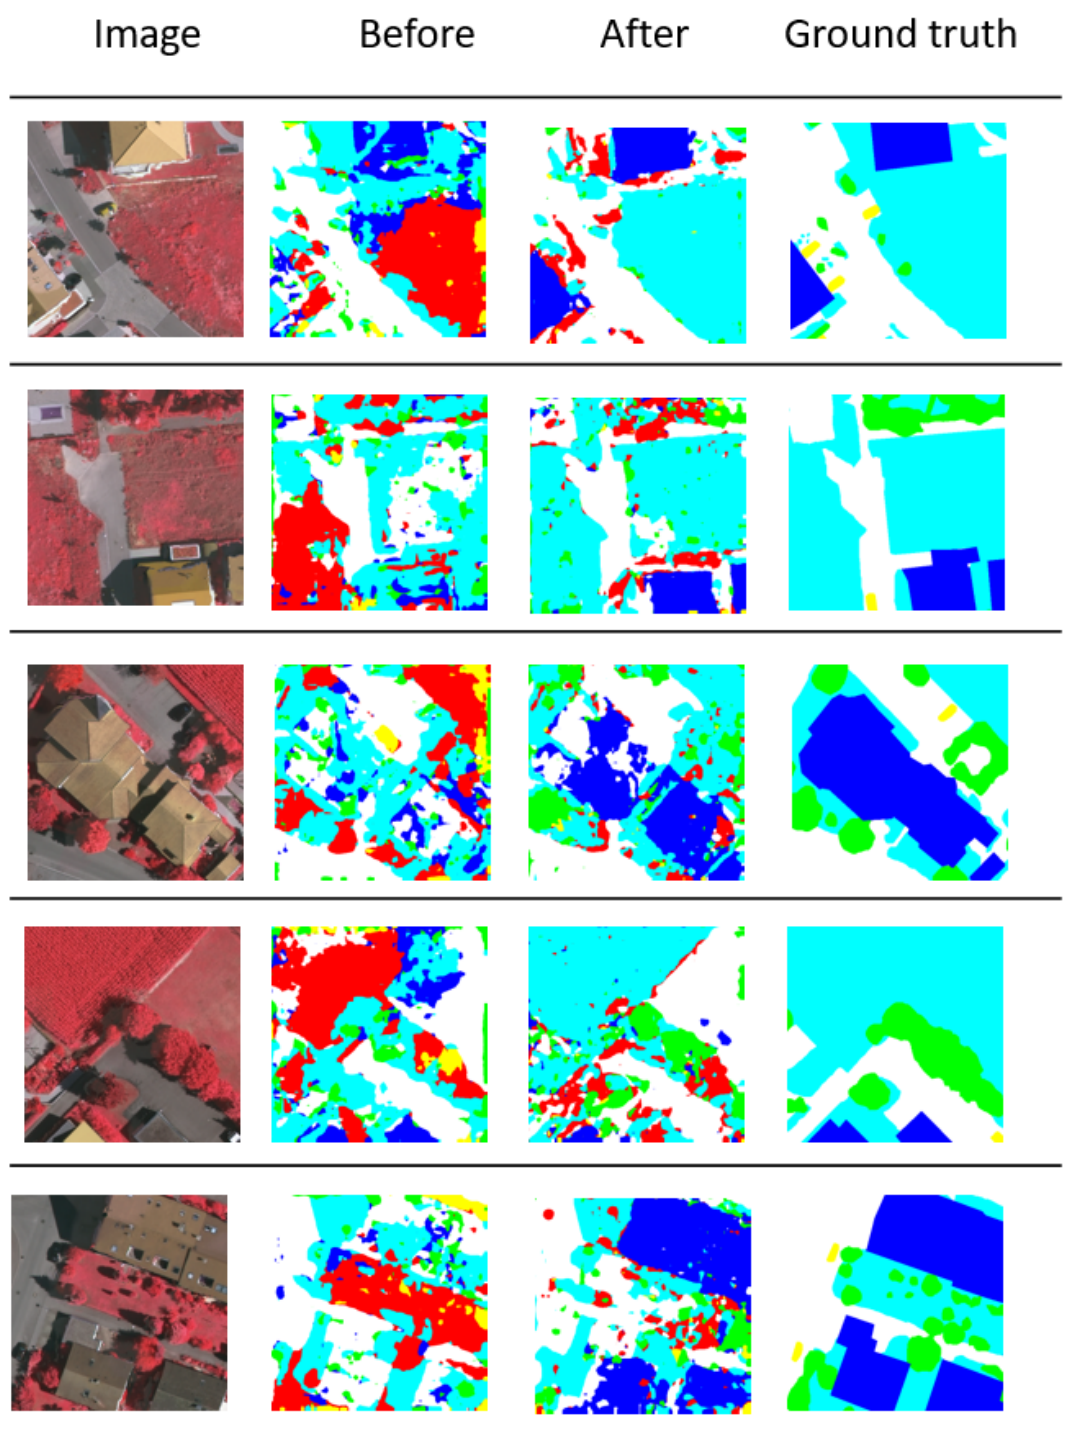
Figure 15. Samples of segmentation before and after implementation of our